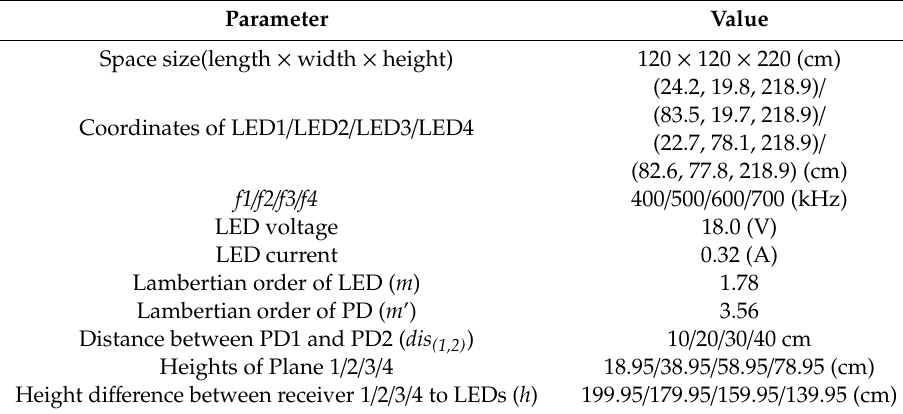
Table 2. Experimental